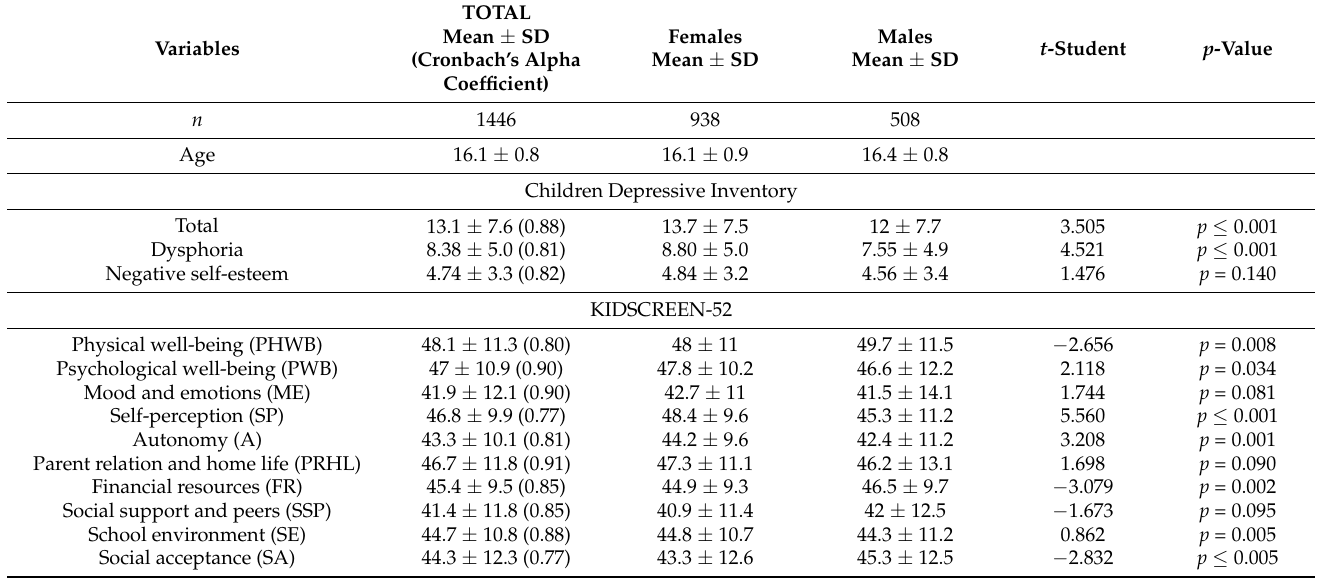
Table 2. Cronbach’s alpha coefficient (CDI-KIDSCREEN-52) stratified by gender.